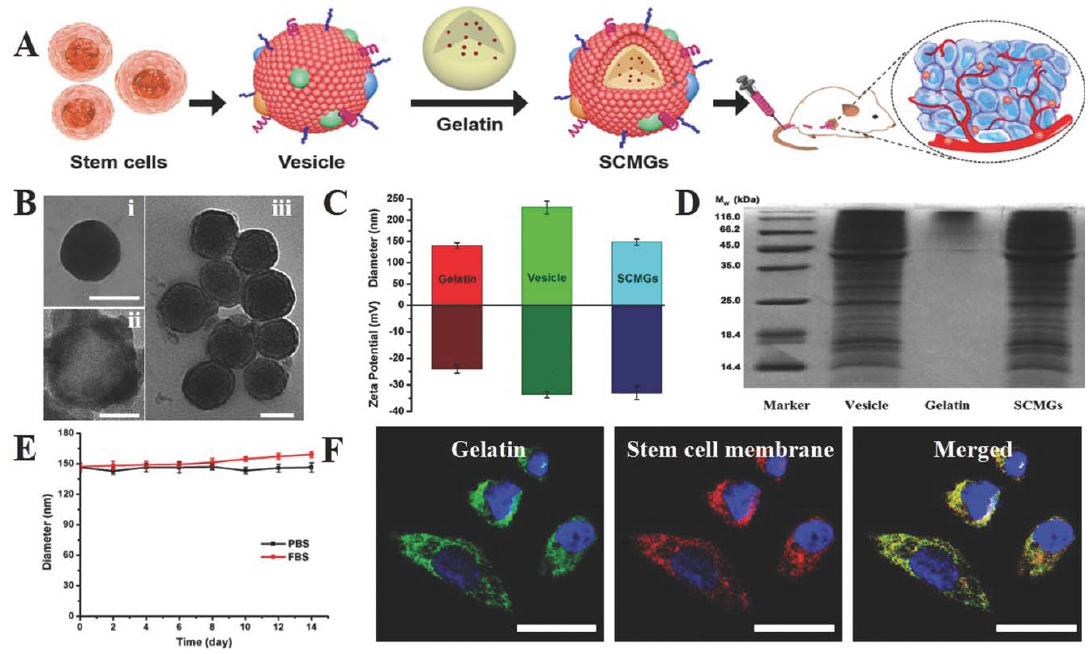
Figure 9. Stem cell membrane ‐ camouflaged gelatin (SCMGs) nanogels loaded with DOX for tumor ‐ targeted delivery of anticancer drugs in vivo. ( A ) Isolation of membranes from stem cells and encapsulation of DOX ‐ loaded gelatin nanogels; ( B ) characterization of stem cell membrane ‐ camouflaged nanoparticles. Transmission electron microscope (TEM) images of (i) bare gelatin nanogel, (ii) stem cell membrane vesicle and (iii) stem cell membrane ‐ coated nanoparticle. Scale bar = 100 nm; ( C ) hydrodynamic particle size and surface zeta potential of bare gelatin nanogels, stem cell membrane vesicles and stem cell membrane ‐ coated nanoparticles; ( D ) sodium dodecyl sulfate– polyacrylamide gel electrophoresis (SDS ‐ PAGE) protein analysis of stem cell membrane vesicles; ( E ) stability of SCMGs in PBS and FBS; ( F ) colocalization of gelatin nanogels (fluorescein isothiocyanate, FITC channel) and stem cell membranes (1,1 ′‐ dioctadecyl ‐ 3,3,3 ′ ,3 ′‐ tetramethylindo ‐ dicarbocyanine, DiD channel) shown by confocal laser scanning microscopy, CLSM images. Scale bar = 20 μ m. Reproduced with permission from Ref [36]. Copyright © 2016, John Wiley and Sons.